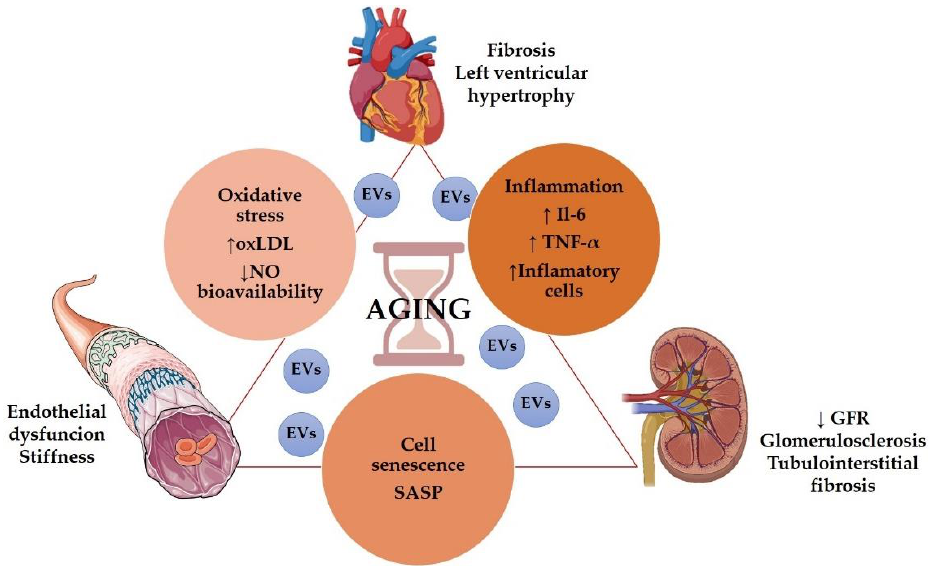
Figure 1. Role of aging in the cardiorenal syndrome. Some graphical elements from this figure were adapted from BioRender (http://biorender.com, accessed on 1 December 2021) and the Servier Medical ART (SMART) Powerpoint image bank (http://smart.servier.com, accessed on 1 December 2021).